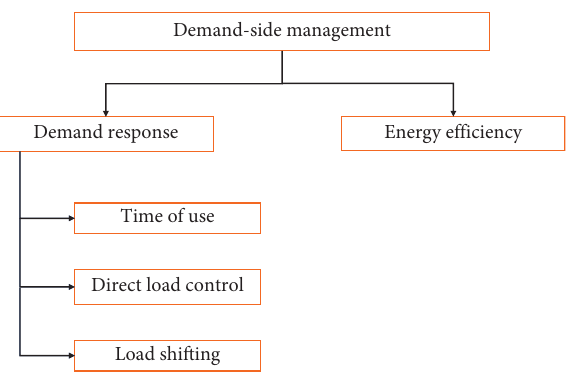
Figure 1: General classification of